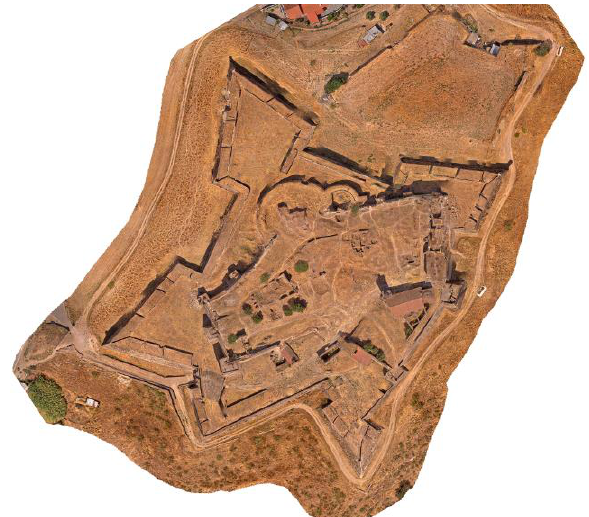
Figure 7. True-Orthoimage based in aerial photogrammetry low-res model.